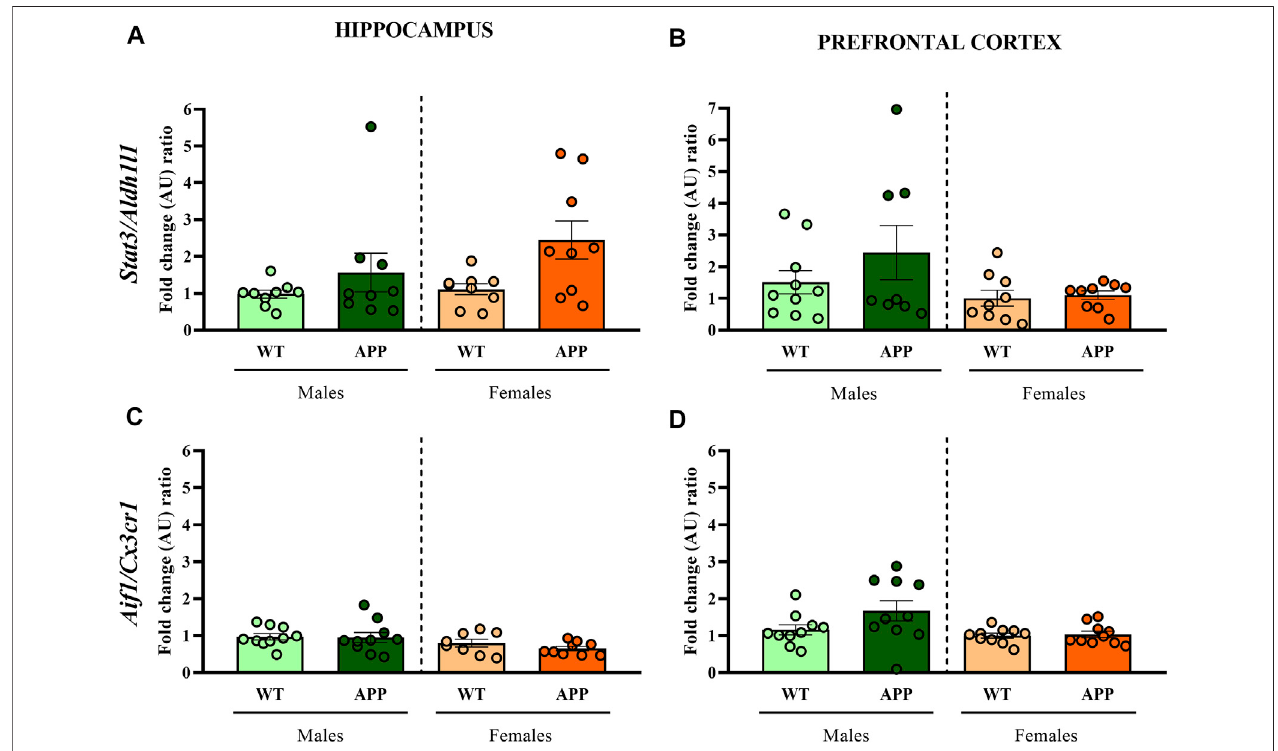
FIGURE 3 | Fold change ratio of Stat3/Aldh1l1 and Aif1/Cx3cr1 in WT (male n = 10; female n = 10) and APP/PS1 (male n = 10; female n = 10) mice. Fold change ratioof Stat3/Aldh1l1 (asaproxyforastrogliosis) and Aif1/Cx3cr1 (asaproxyformicrogliosis)inthe (A,C) hippocampus and (B,D) prefrontalcortex respectively, ofmale and female WT and APP/PS1 mice at 3 months of age. The X axis shows the four groups analyzed: male APP/PS1 mice compared with their corresponding WT littermates, and female APP/PS1 mice compared with their control group. The Y axis shows the mRNA expression as a fold change ratio. Values are presented as the mean ± SEM; (Mann – Whitney